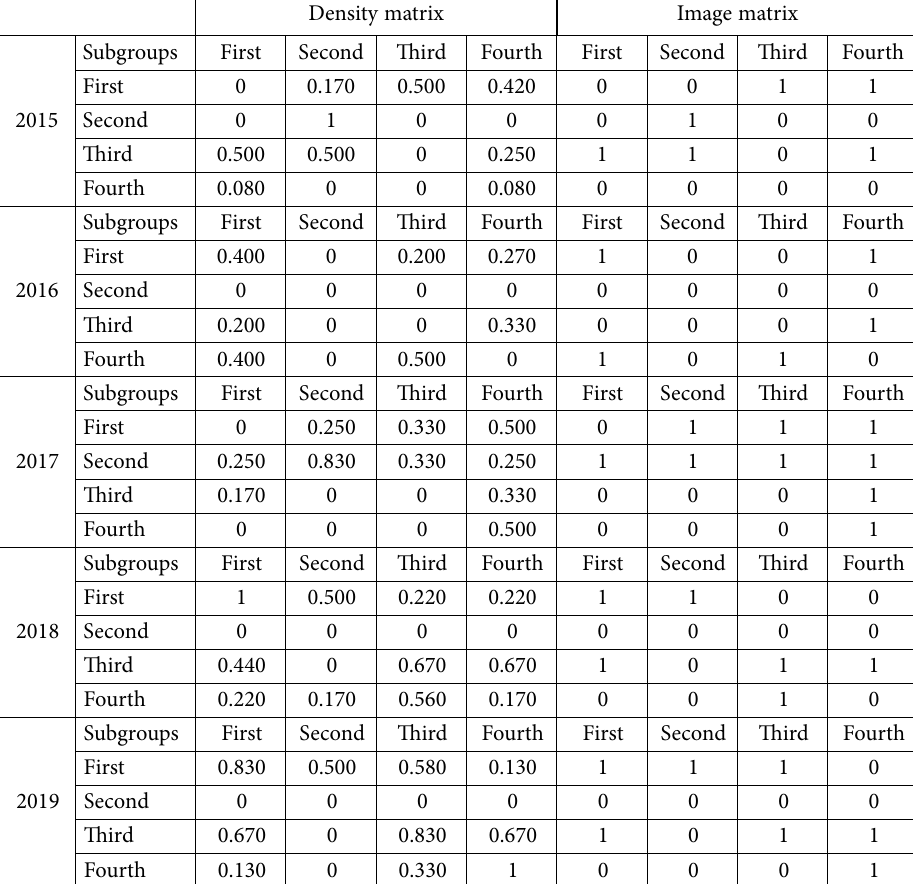
Table A1. Density matrix and image matrix table of the GBA’s green development spatial association network Density matrix Image